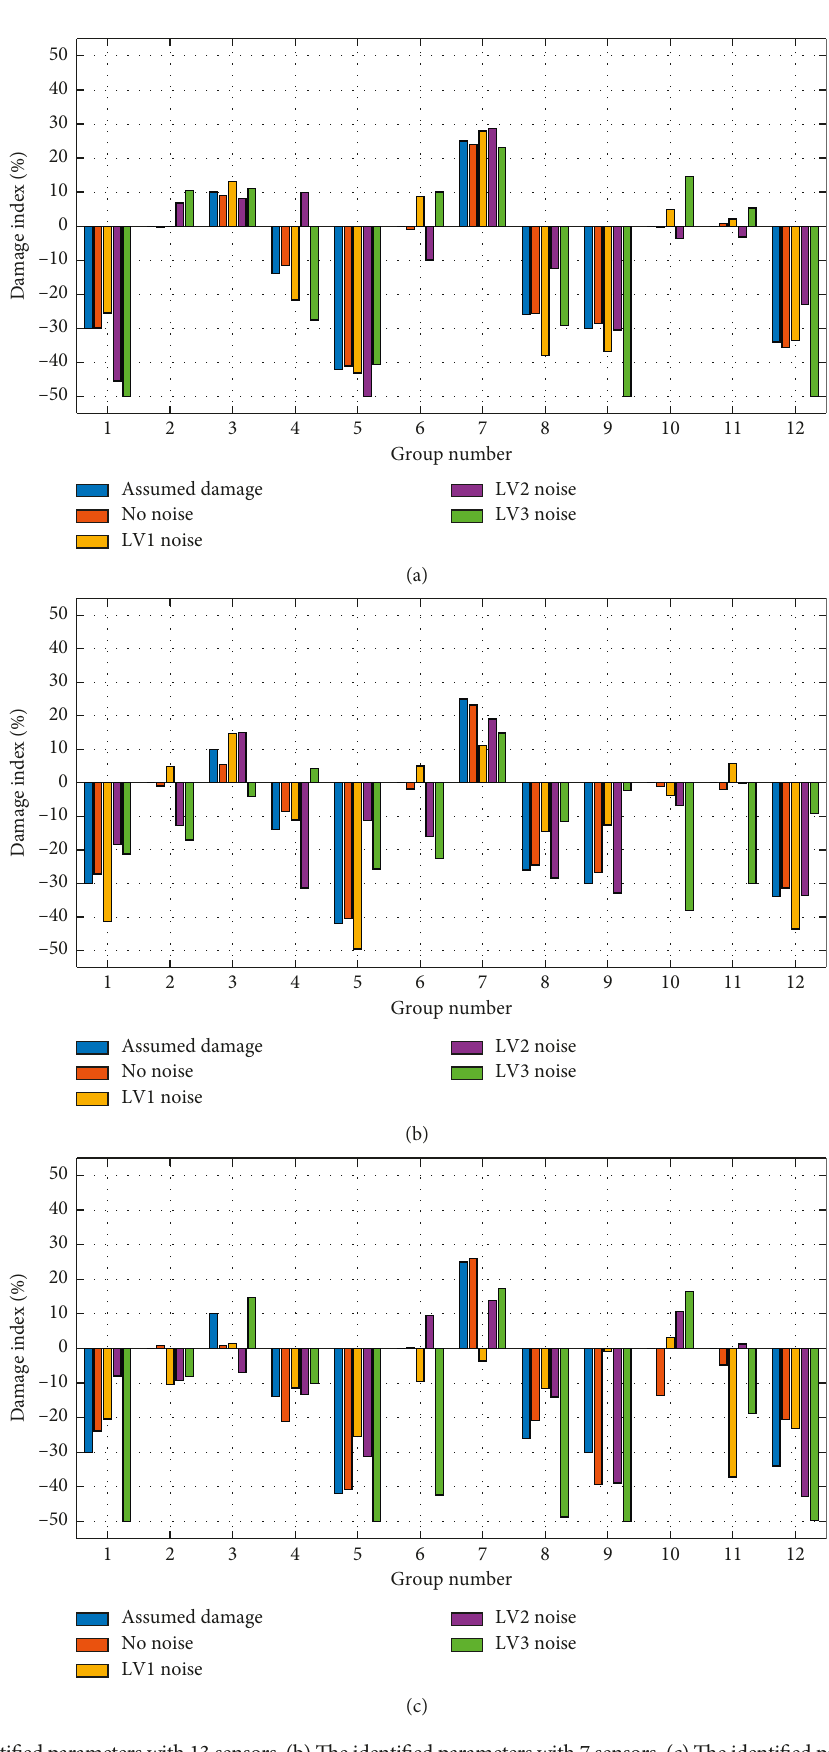
Figure 15: (a) The identified parameters with 13 sensors. (b) The identified parameters with 7 sensors. (c) The identified parameters with 5